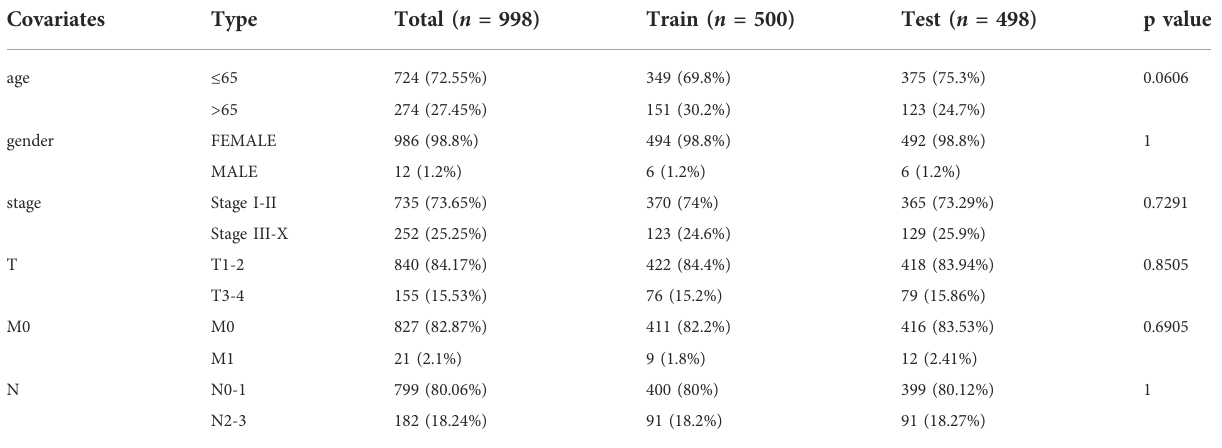
TABLE 1 Clinical characteristics of included patients.